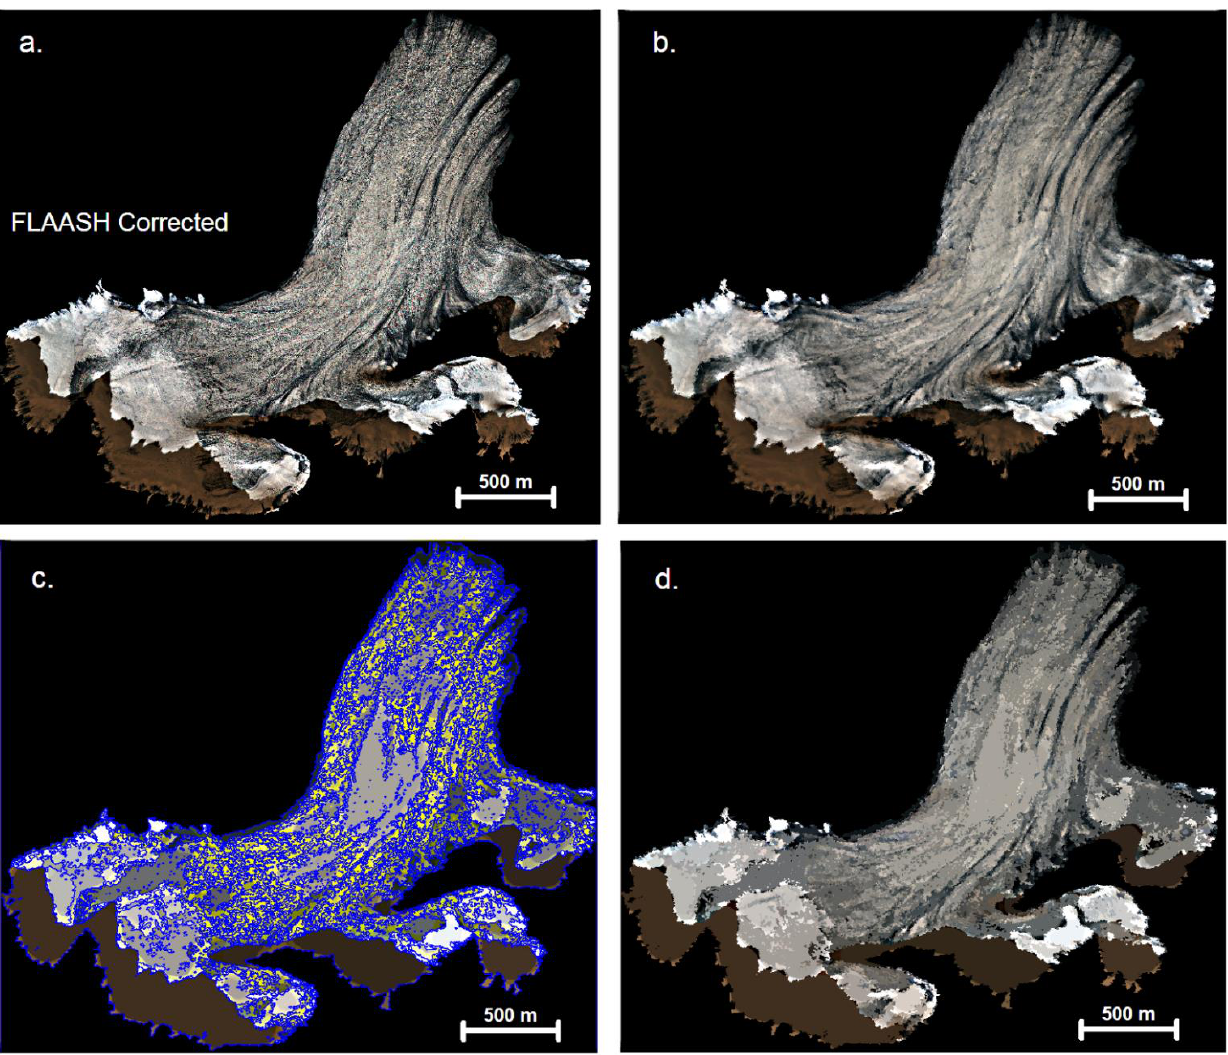
Figure 3. Segmentation and classification on the ML FLAASH subset. ( a ) Non-segmented Image; ( b ) Segmented Object Mean View: Hidden Outlines; ( c ) Classified Merged Objects: Visible Object Outlines; ( d ) Classified Merged Objects: Hidden Outlines. RGB: Coastal, Blue, Green.